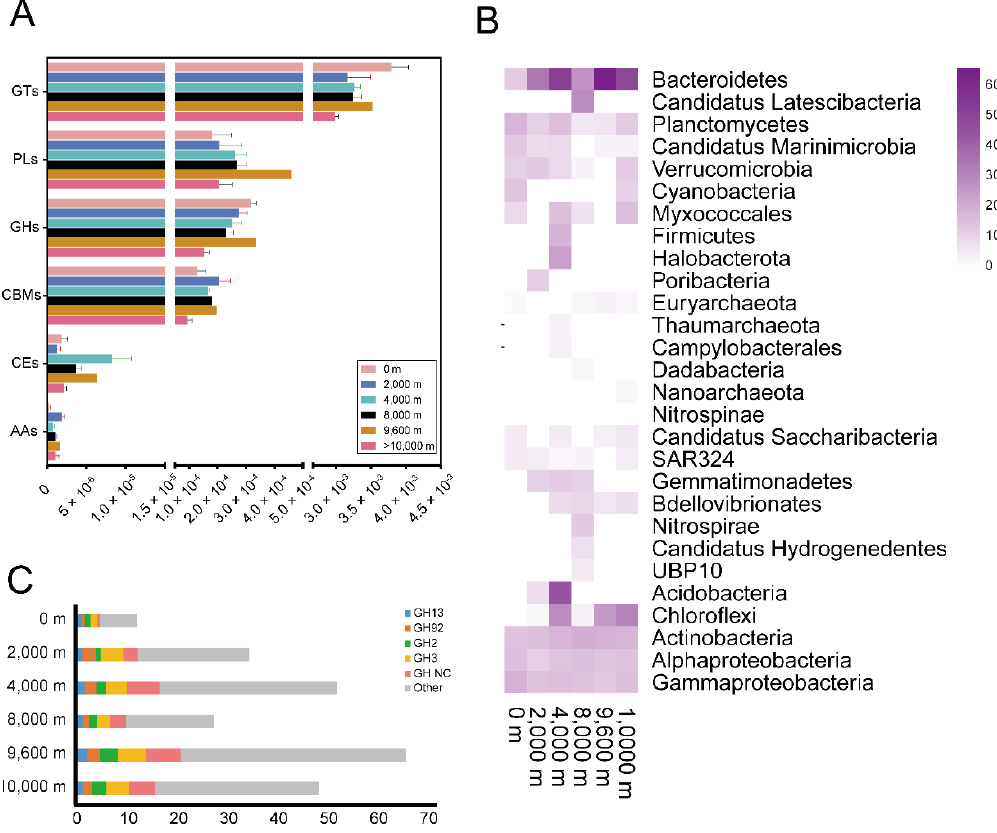
Figure 4. The relative abundances of genes involved in the microbial degradation pathways of carbohydrates across different water depths in the Mariana Trench ( A ). GTs, glycosyltransferases; PLs, polysaccharide lyases; GHs, glycoside hydrolases; CBMs, carbohydrate ‐ binding modules; CEs, carbohydrate esterases; AAs, auxiliary activities. The number of glycoside hydrolases in the MAGs across different water depths in the Mariana Trench ( B ). The number of the main glycoside hydrolase from Bacteroidetes across different water depths in the Mariana Trench ( C ).